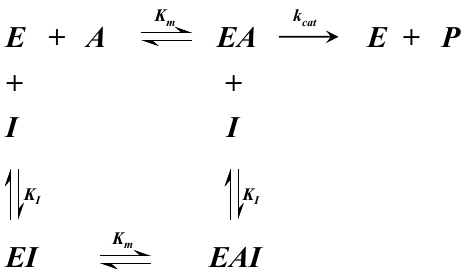
Figure A1. Single substrate Michaelis-Menten kinetics and competitive inhibition of species A through I.